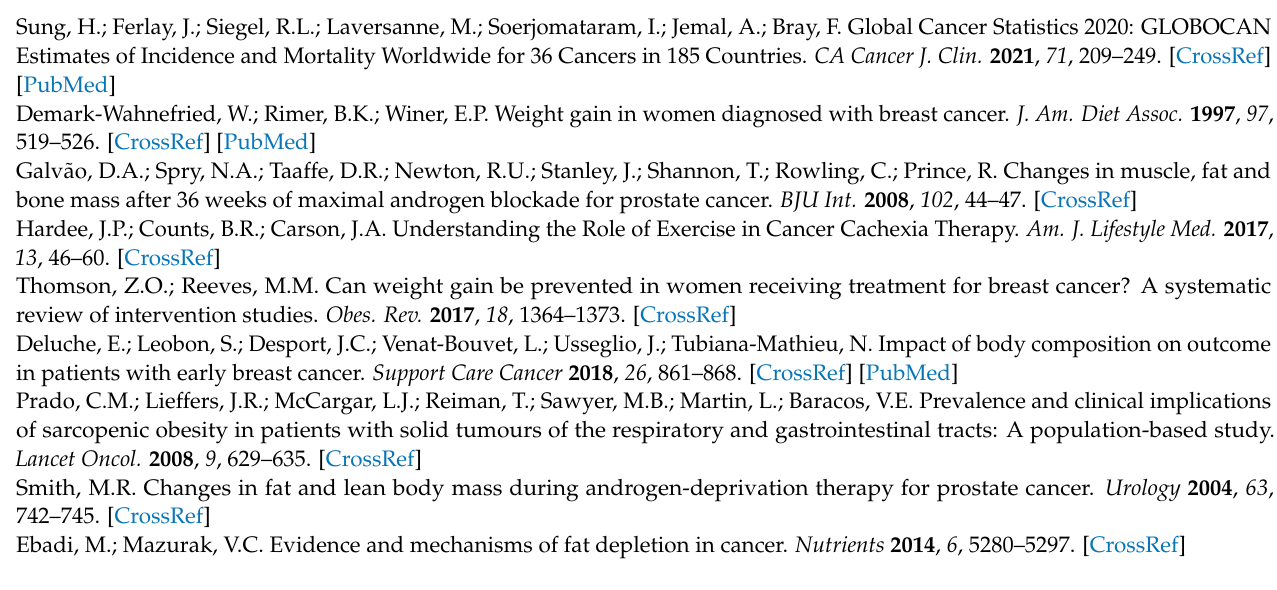
April 2022. Table S2: Quality assessments of included studies using by MMAT. Table S3: Mentioned outcomes related to SPA. Supplementary data to this article can be found in the paperwork we filed